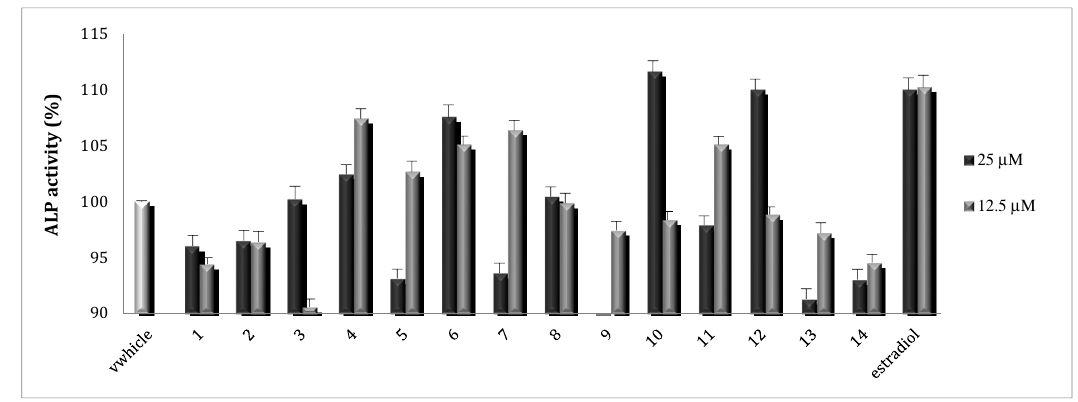
Figure 4. ALP activity of 1 – 14 toward MC3T3-E1 cell lines.